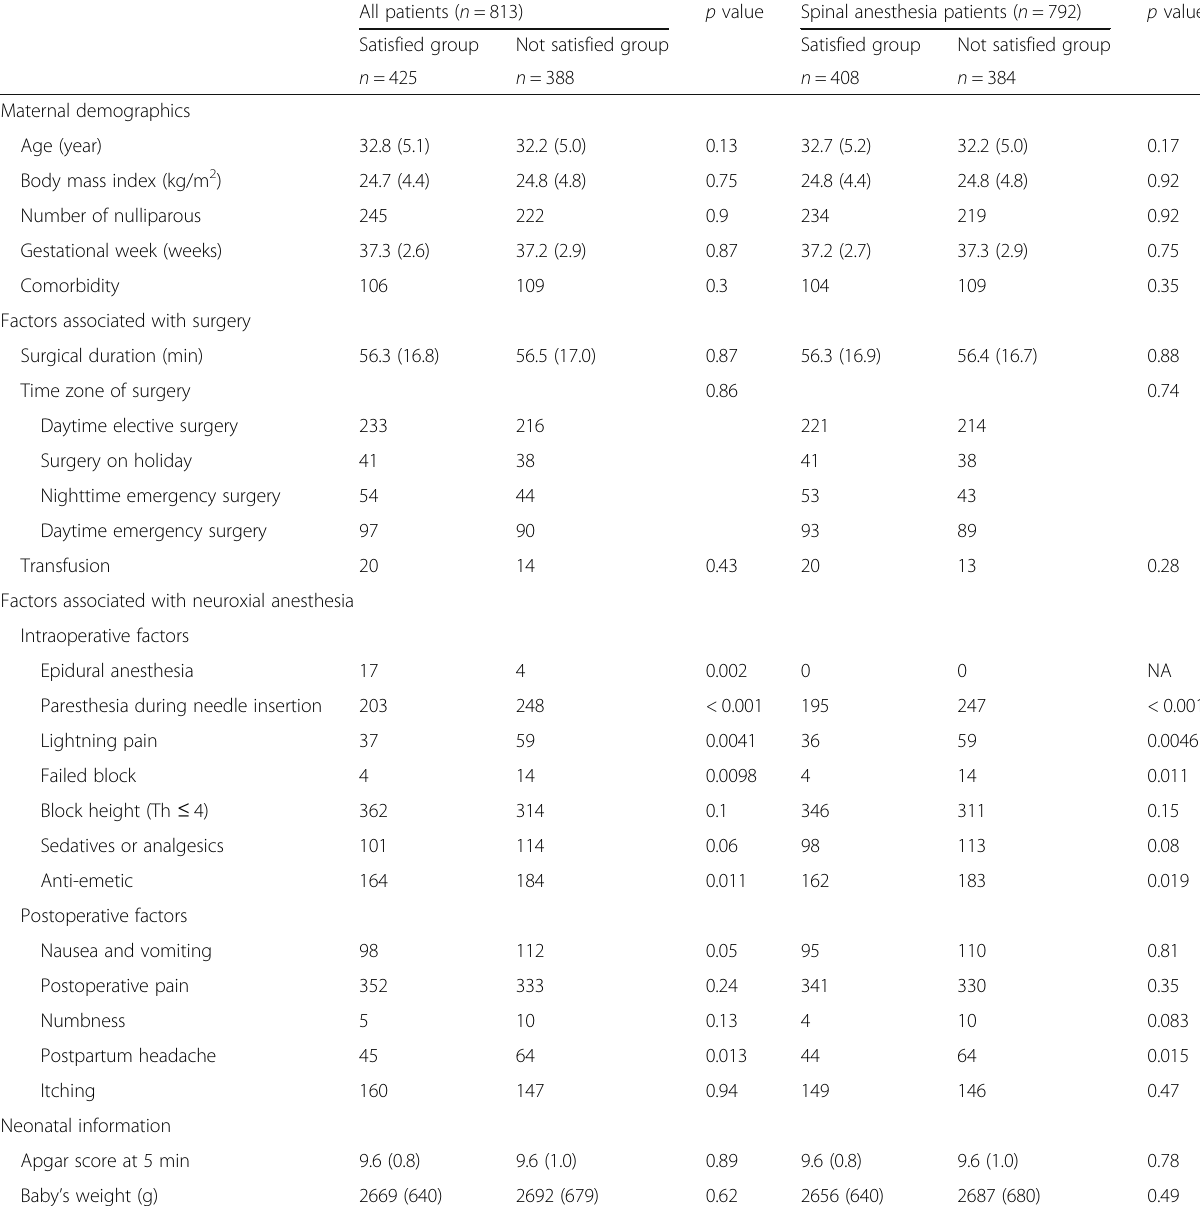
Table 1 Univariate analysis between the satisfied and not satisfied groups All patients ( n =